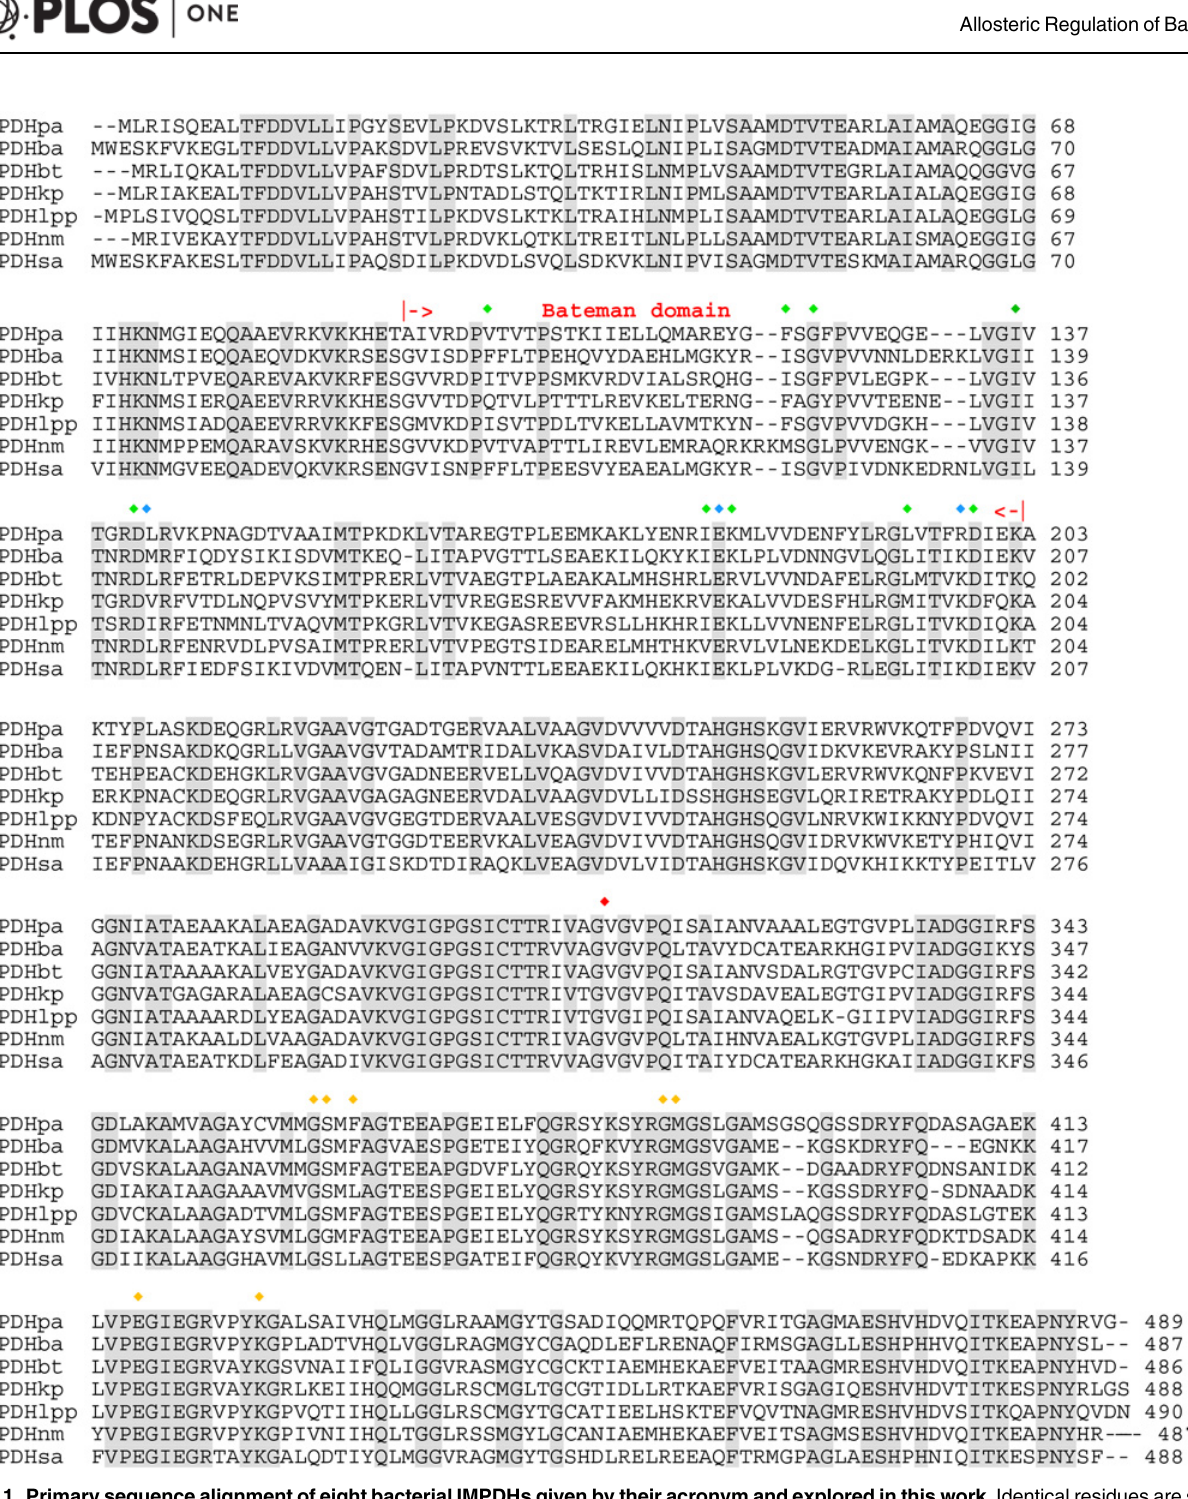
Fig 1. Primary sequence alignment of eight bacterial IMPDHs given by their acronym and explored in this work. Identical residues are shaded. CBS modules of IMPDHpa are marked out by arrows. IMPDHpa residues involved in the interaction with ATP, Mg and IMP are marked out by red, green and yellow diamonds, respectively. The catalytic cysteine residue is marked out by a red diamond. ba: Bacillus anthracis ; bt: Burkholderia thailandensis; kp: Klebsiella pneumonia ; lpp: Legionella pneumophila subsp. pneumophila ; nm: Neisseria meningitidis ; pa: Pseudomonas aeruginosa ; sa: Staphylococcus aureus